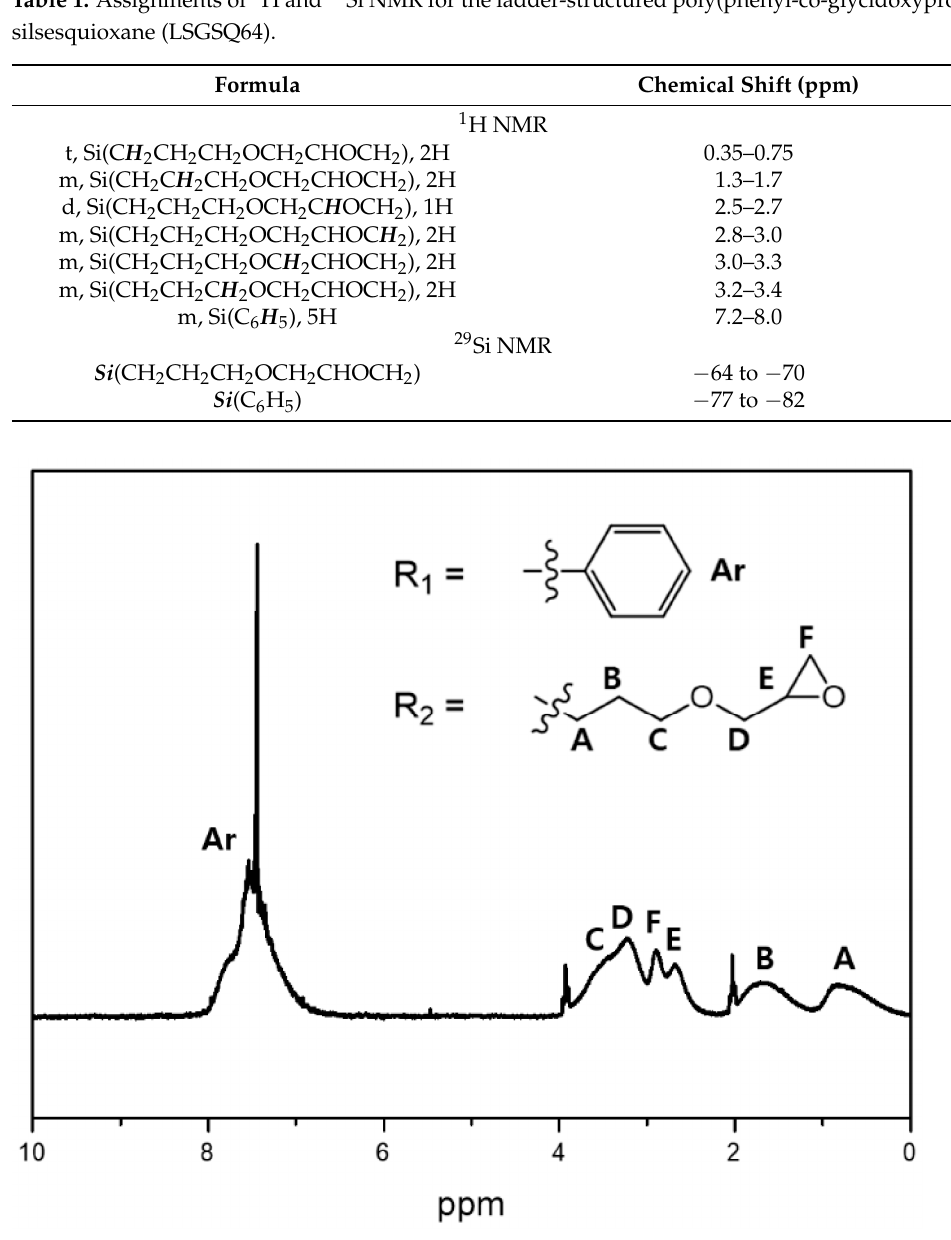
Figure 1. 1 H NMR spectrum of poly(phenyl-co-glycidoxypropyl) silsesquioxane (LSGSQ64). The obtained LPGSQ64 polymer was then utilized as a polymer matrix to form lanthanide-based composite films with highly compatible interactions between lanthanide ions and the terminal silanol groups of LPGSQ64, as presented in Scheme 1b [31]. To fabricate the luminescent hybrid films, the precursor solutions were first made by mixing a certain amount of lanthanide precursors (Eu 3+ and Tb 3+ ) in a 20 wt% LPGSQ64 in THF solution, then drop-cast onto the glass substrate and kept at room temperature from 5–10 min. Second, 60 ◦ C preheating was applied in ambient air for 30 min to produce a transparent film. Finally, a fluorescent film was obtained after the heat treatment at 180 ◦ C in ambient air for 6 h. Figure 2a presents the film fabrication process, where Eu 3+ generates red-emission color under UV light irradiation and Tb 3+ generates green emission, respectively. Figure 2b shows the fabricated films cured at 180 ◦ C for various heat treatment intervals (from 0 to 6 h), illuminated under a UV lamp ( λ = 365 nm). The film was fabricated immediately after the solvent evaporation at 60 ◦ C, but it lacked color emission